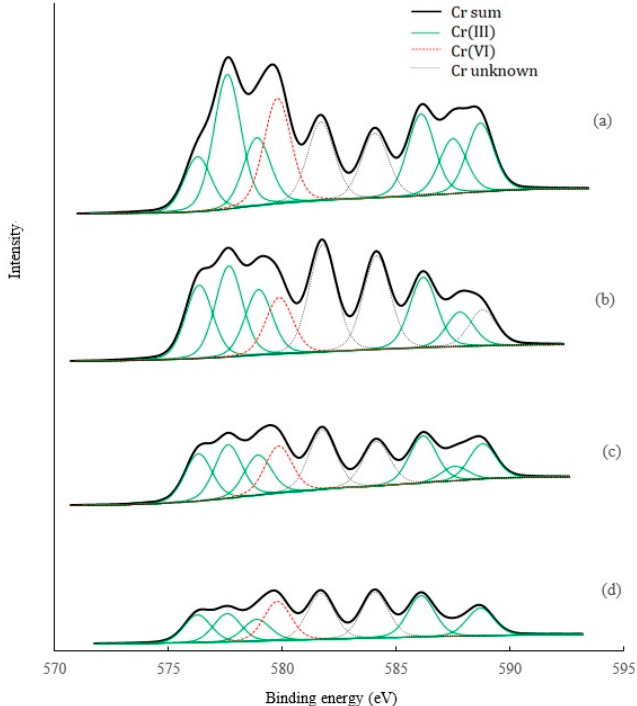
Figure 7. XPS analysis of Cr species in the soils before and after leaching by different acids. ( a ) Original soil, ( b ) soil leached by HCl, ( c ) soil leached by CA, ( d ) soil leached by